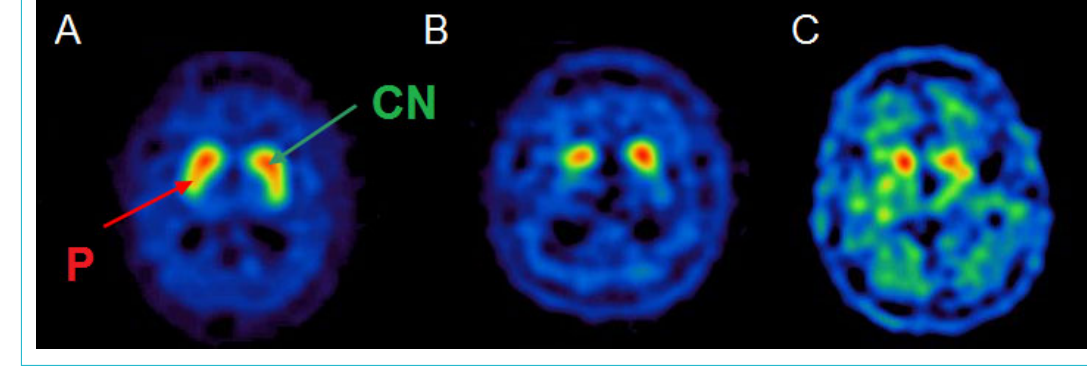
Figure 2: Axial 123 I-FP-CIT SPECT (ioflupane, DaTSCAN ® ) showing a preserved “comma-shaped” uptake in a healthy subject (A) with pre- served uptake for both caudate nucleus (CN, green arrow) and putamen (P, red arrow). We can observe typical asymmetric and mostly putam- inal uptake reduction in Parkinson’s disease (B), and a severe uptake impairment involving the whole striatum in a patient with PSP